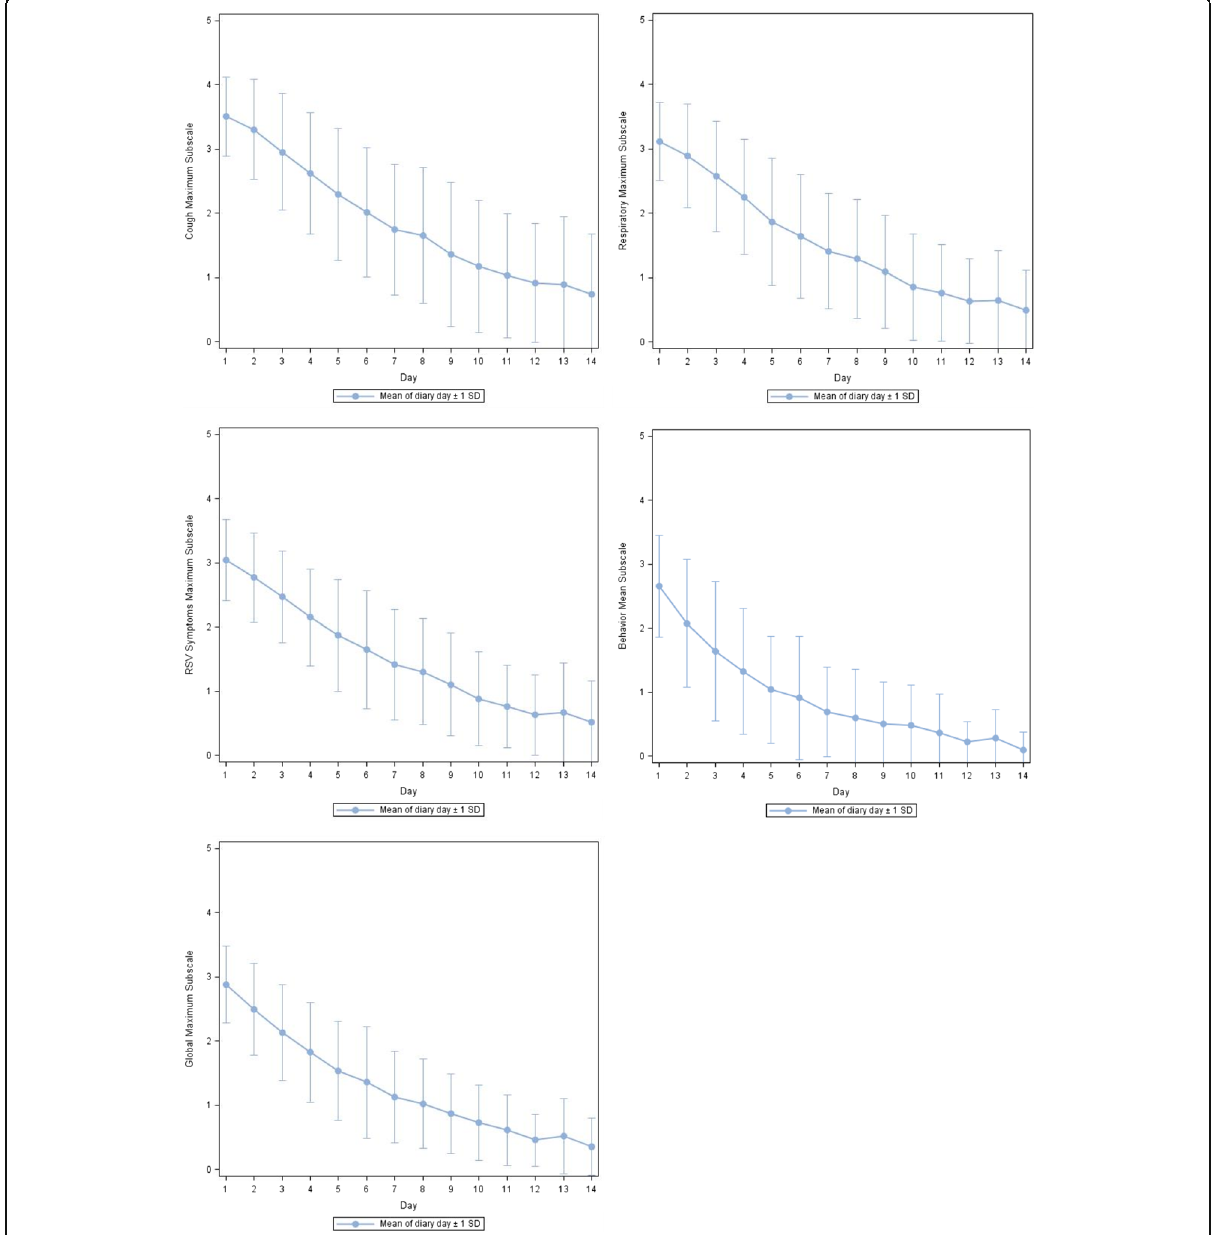
Fig. 2 Subscale-level line plots displaying average GRCD subscale scores over the course of the study, GRCD=Gilead RSV Caregiver Diary; SD=standard deviation. Note: The Cough subscale included 4 items on daytime and overnight cough frequency and severity; the Respiratory subscale included 8 items on shallow breathing, noisy breathing, and cough frequency and severity; the 10-item RSV Symptoms subscale included shallow breathing, noisy breathing, cough frequency and severity, runny nose, and stuffy nose; and the 4-item Behavior Impacts subscale included overnight sleep and daytime eating,